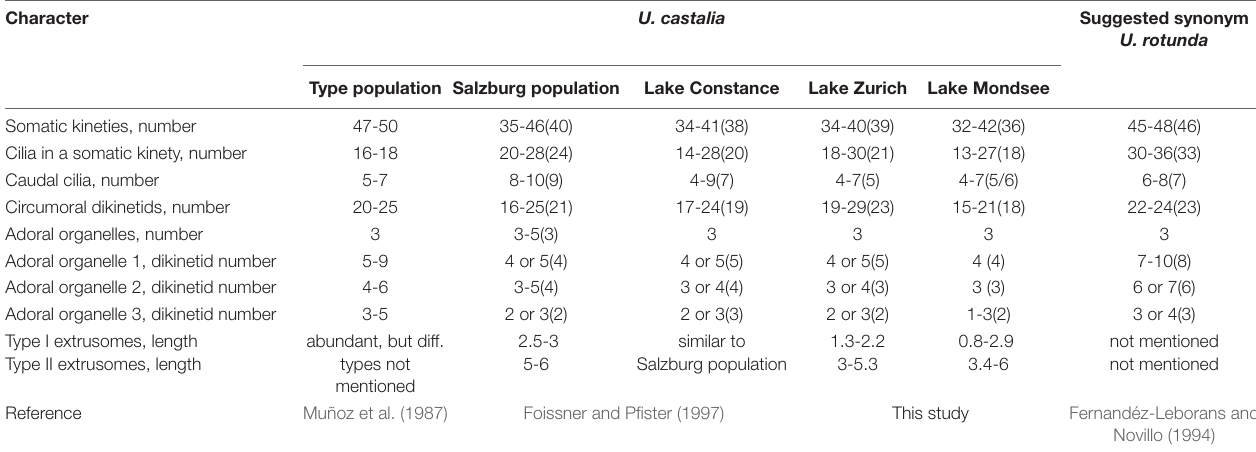
TABLE 5 | Comparison of main characters in the Urotricha castalia -complex based on stained material (average values given in